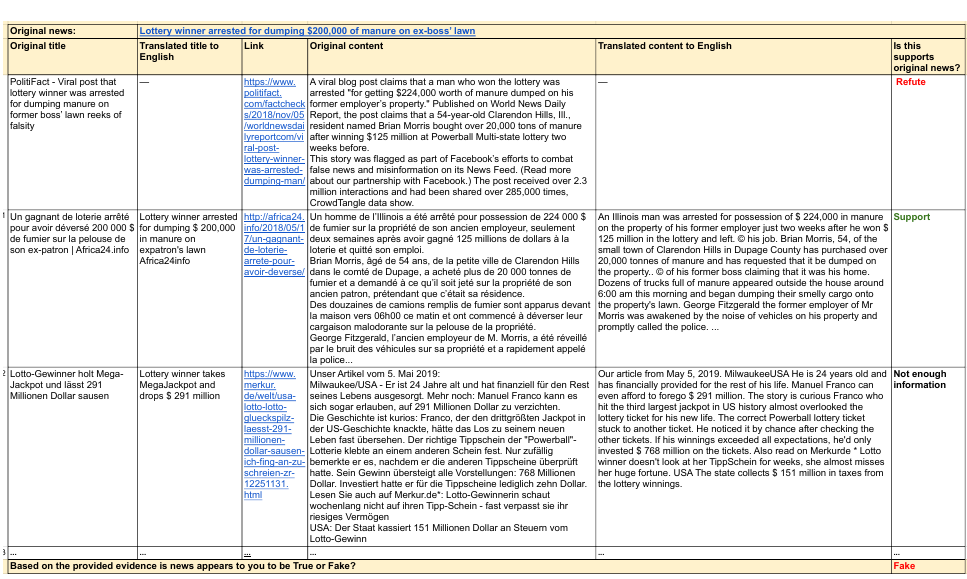
Figure 3. User interface that was used for the answer collection (for manual verification). The annotator was provided with original news and the link to the source. After that, the annotator was given the results of the cross-lingual search results translated into English if needed. For each news item from the search results, the title, link to the source, and text of the content were provided. The task assigned to the annotator was to determine whether the scraped news supported, refuted, or provided insufficient information to verify the original news. In the final step, the annotator was asked to classify the original news as either fake or